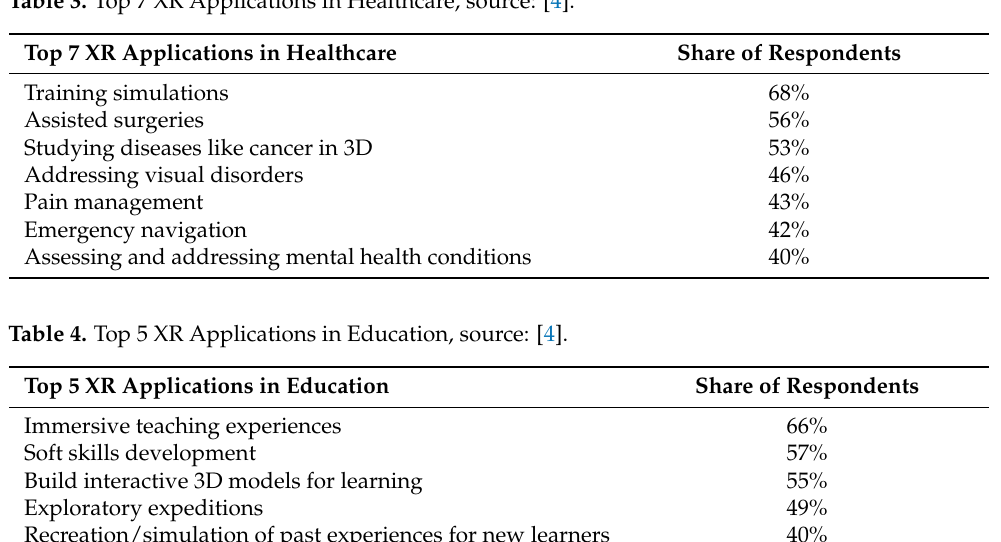
Table 3. Top 7 XR Applications in Healthcare, source: [4].